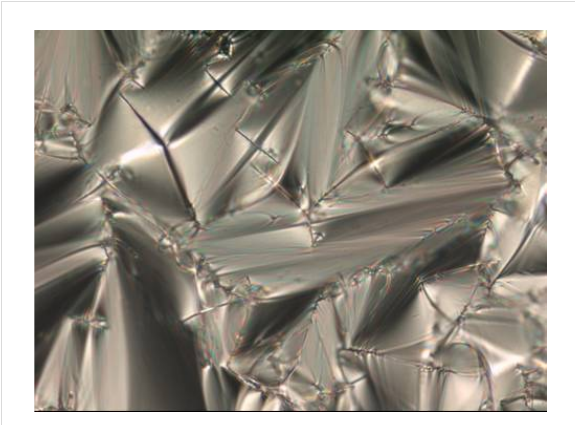
Figure 6: Fan-shaped texture of compound 6e at 45 °C upon cooling from the isotropic liquid (cooling rate 10 K/min) (magnification